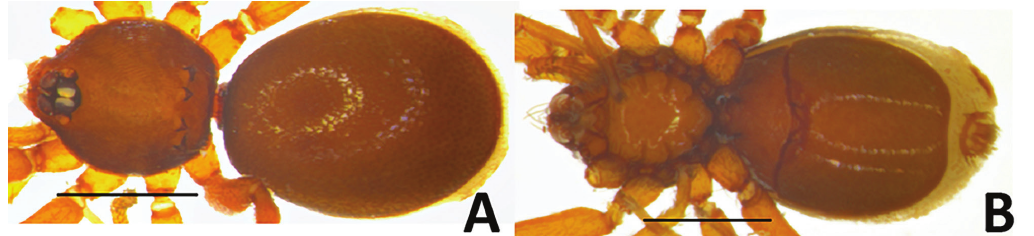
Figure 9. Opopaea spinosiscorona n. sp., female from Kurulukelle FR: A , habitus, dorsal view; B , same, ventral view. Scale bars: 0.5 mm.